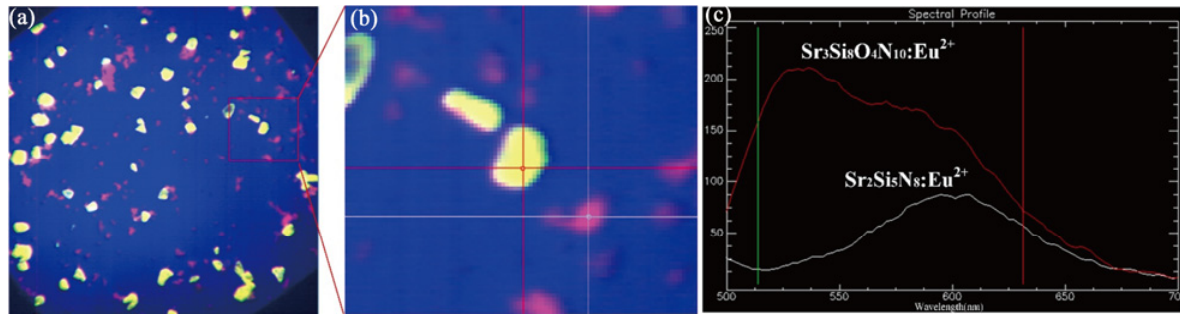
Fig. 10 Microscopic imaging spectroscopy images applied to the investigated powder mixture. (a, b) Sr 3 Si 8 O 4 N 10 :Eu 2+ (yellow) and Sr 2 Si 5 N 8 :Eu 2+ (pink) particles in original field of view and the enlarged field of view, respectively; (c) emission spectra of Sr 3 Si 8 O 4 N 10 :Eu 2+ (red) and Sr 2 Si 5 N 8 :Eu 2+